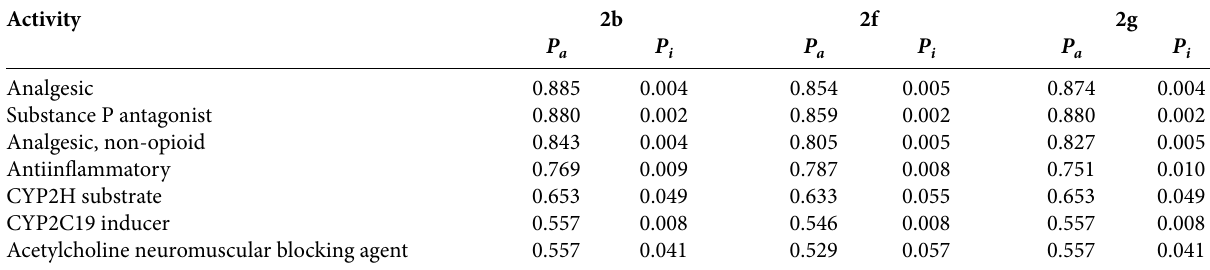
Table 6. Biological activity assessment using PASS online software. Activity